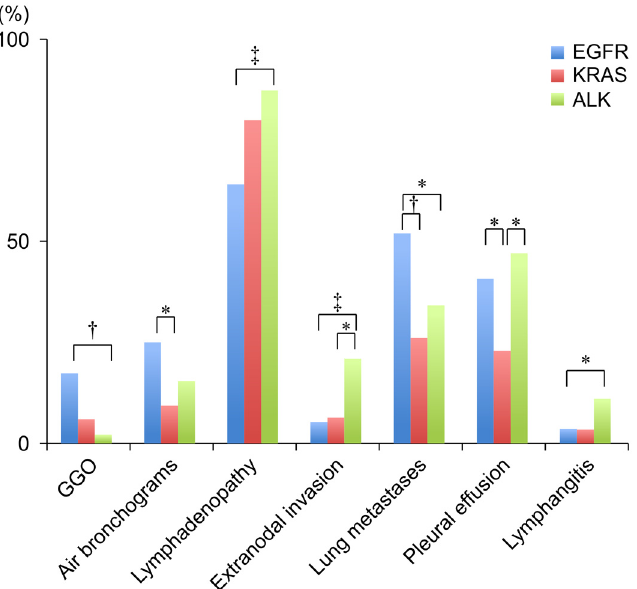
Fig 2. The relative distributions of the main tumor and intra-thoracic characteristics among stage IIIB – IV patients with lung adenocarcinoma. * P < 0.05; † P < 0.01; ‡ P < 0.005.